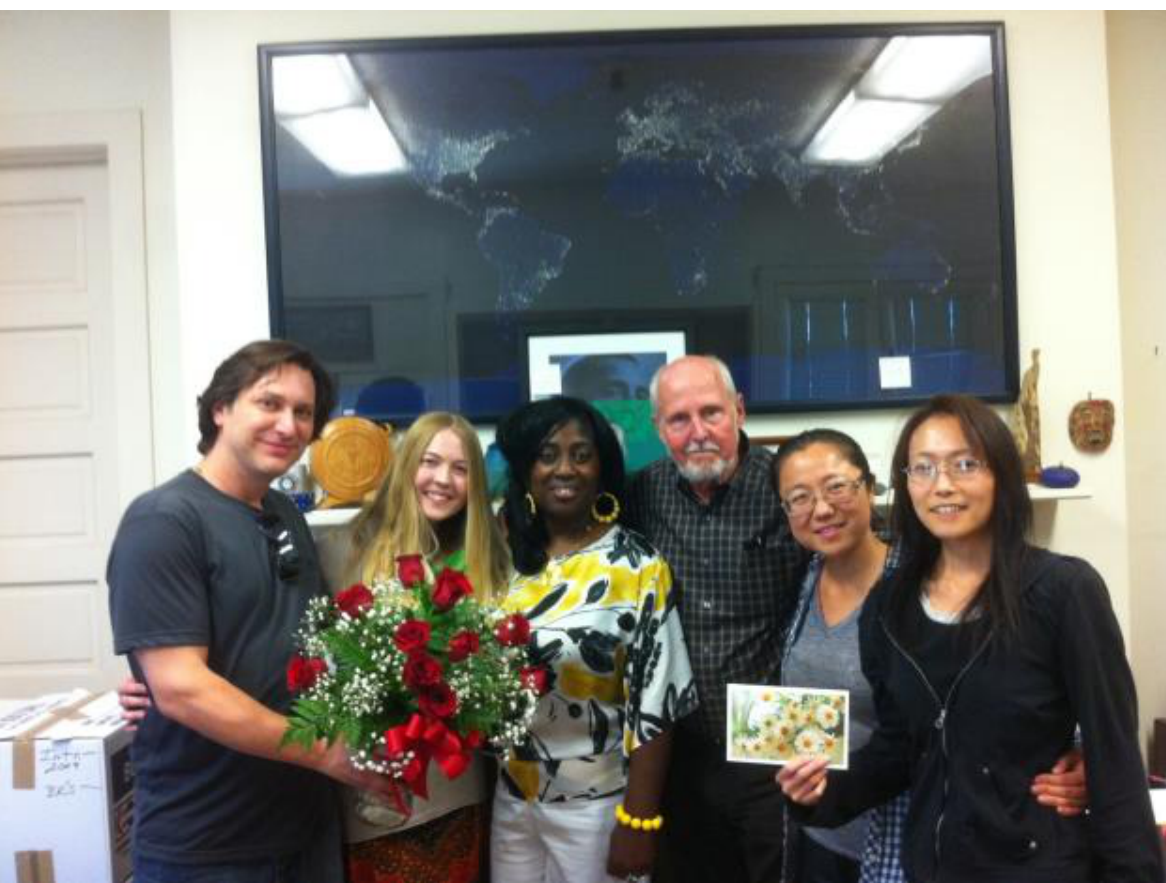
Figure 4. IROWS Colleagues at College Building South (Alexis Alvarez, Rebecca Alvarez, Nelda Thomas, Chris Chase-Dunn, Lulin Bao and Hiroko Inoue)